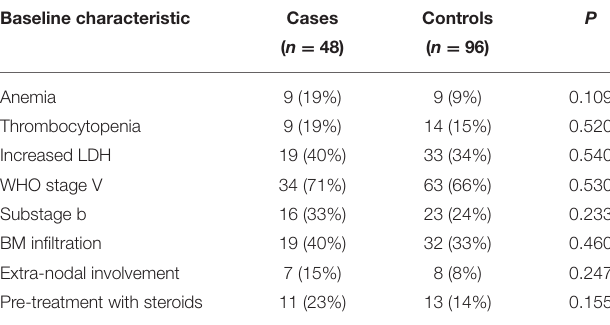
TABLE 2 | Distribution of baseline characteristics in cases and matched controls obtained via incidence density sampling.